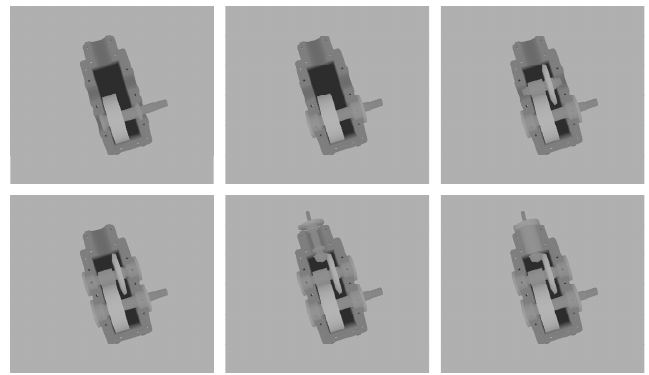
Figure 5. Synthesized assembly depth image dataset.